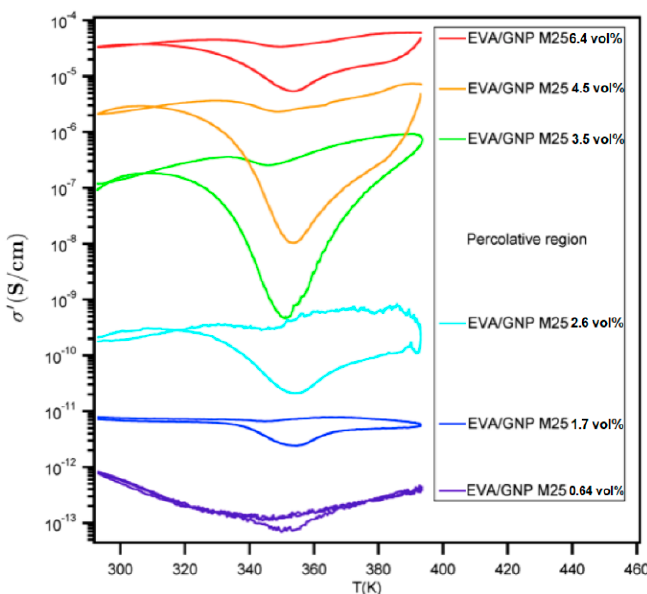
Figure 5. Thermal cycling effect on conductivity for the EVA20/GNP compositions of different filling. For all systems both below and above the indicated percolative region, there appears to be a limited change in conductivity upon cooling. Table 3. Characteristics of the conductivity as a function of temperature for the EVA20/GNP systems. GNP